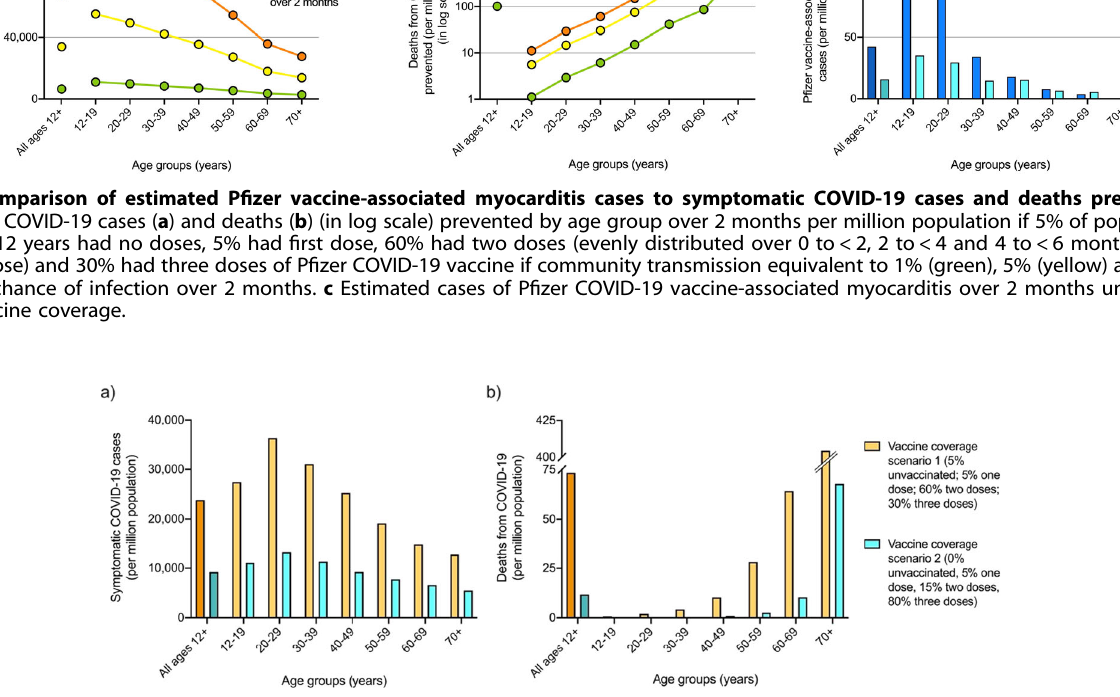
Fig. 4 Estimated symptomatic COVID-19 cases and deaths under different vaccination coverage scenarios. Comparison of expected number of COVID-19 cases ( a ) and deaths ( b ) per million population by age groups under vaccine coverage scenario one (5% of population of ages ≥ 12 years had no doses, 5% had fi rst dose, 60% had two doses [evenly distributed across time since second dose], and 30% had three doses of P fi zer COVID-19 vaccine), versus coverage scenario two (0% of population had no doses, 5% had one dose, 15% had two doses [evenly distributed across times since second dose] and 80% had three doses), under a transmission scenario equivalent to 10% chance of infection over 2